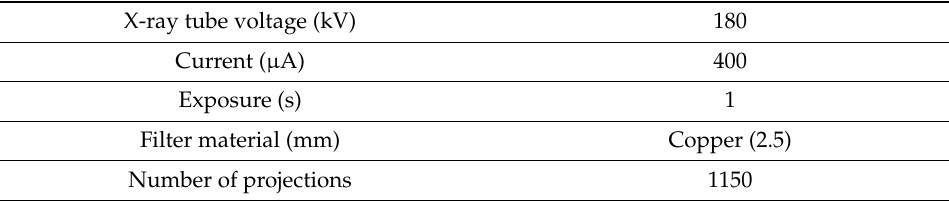
Table 1. CT scan parameters of the KH-09-09